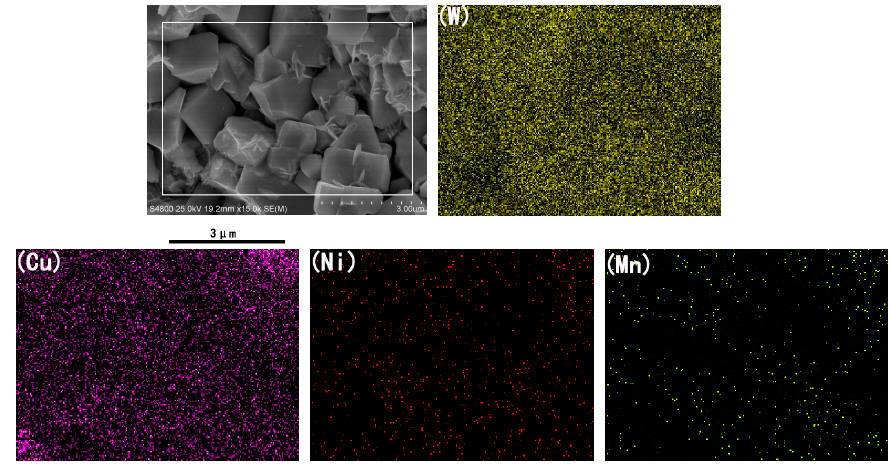
Figure 3. EDS element mappings of W, Cu and Ni for the fracture morphology of sample S5.